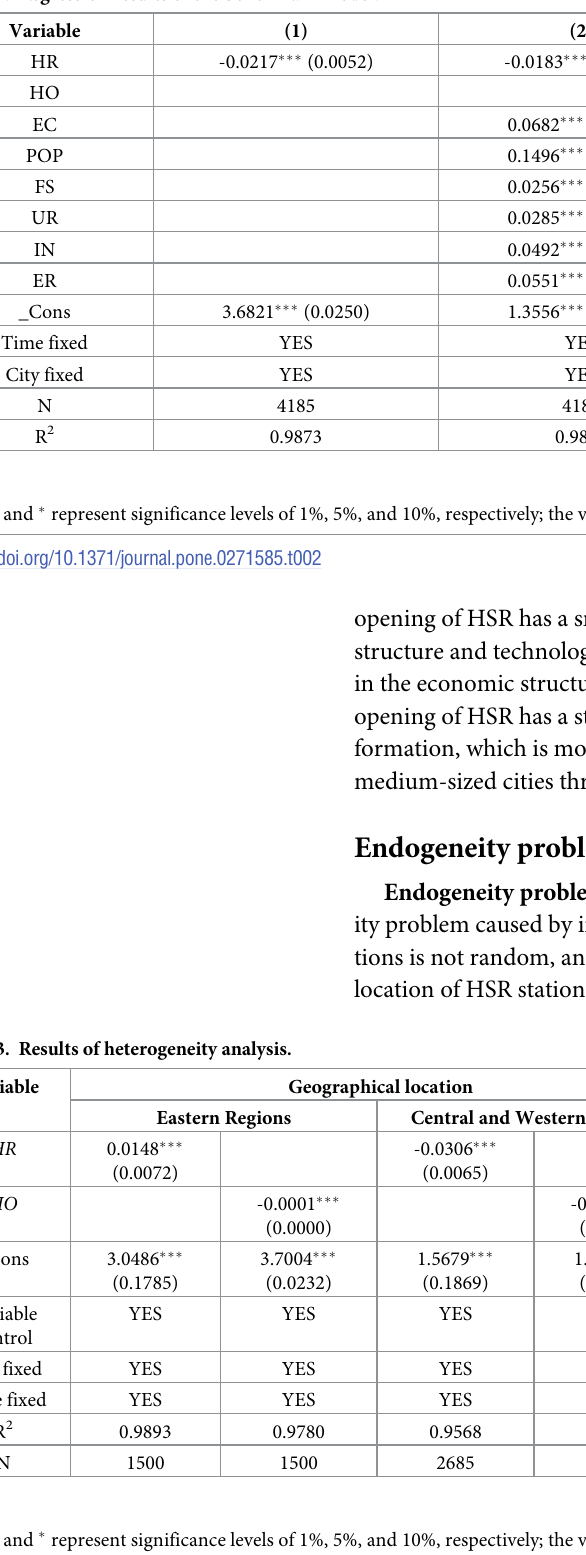
Table 2. Regression results of the benchmark model.